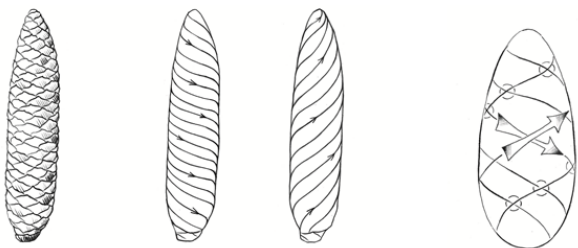
Figure 4. Left: diagrammatic representation of two “energy flows (male downwards / female upwards)” intersecting in a helical fash- ion (in Coats 1996). Right: Spatial arrangement of the seed location at the intersections of the spiral patterns characteristic of the spe- cies; the seed represent dormant meristematic points, destined to develop as new specimen. Drawing D.